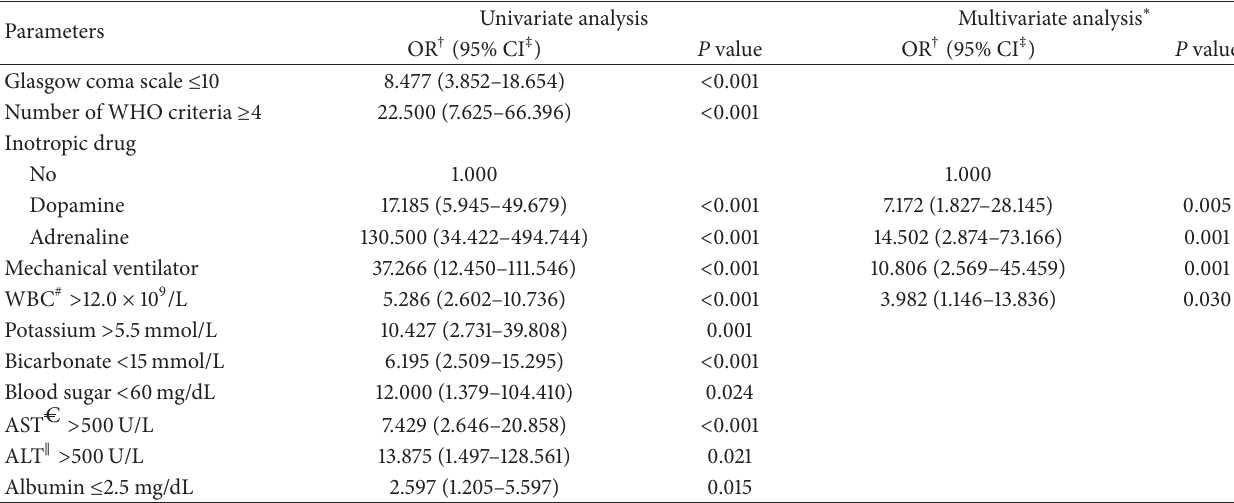
Table 3: Univariate and multivariate logistic regression analysis of risk factors for in-hospital mortality among severe falciparum malaria patients with acute kidney